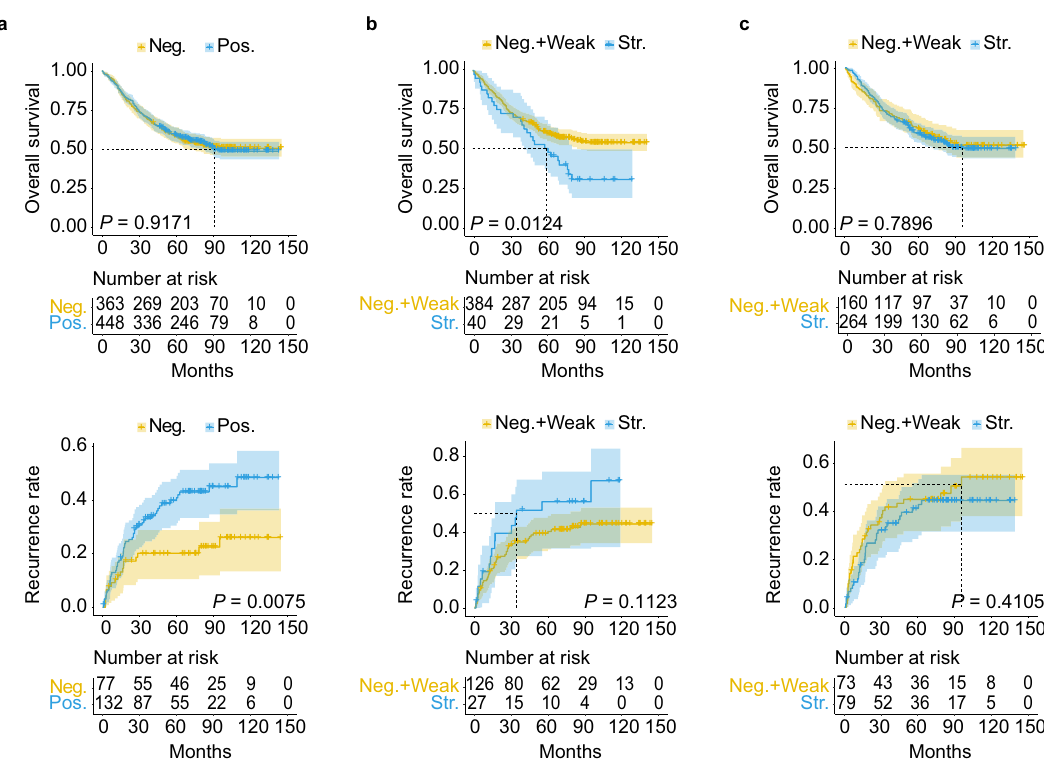
Fig. 6 Kaplan – Meier survival analysis of three diagnostic biomarkers in patients with colorectal adenocarcinoma. a , b , c The overall survival (OS) and recurrence-free survival (RFS) curves of CORO1C ( a ), RAD23B ( b ), and ARPC5 ( c ). The survival curve with 95% con fi dence interval in shading was plotted for each group. P values were calculated by two-sided log-rank test. The numbers at the bottom of each panel indicate the patients at risk. Neg. negative, Pos. positive, Weak weak expression, Str . strong expression. The source data are provided in Source